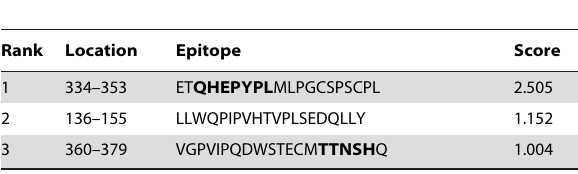
Table 2. Epitopes predicted by the SVMTriP inside the PAP